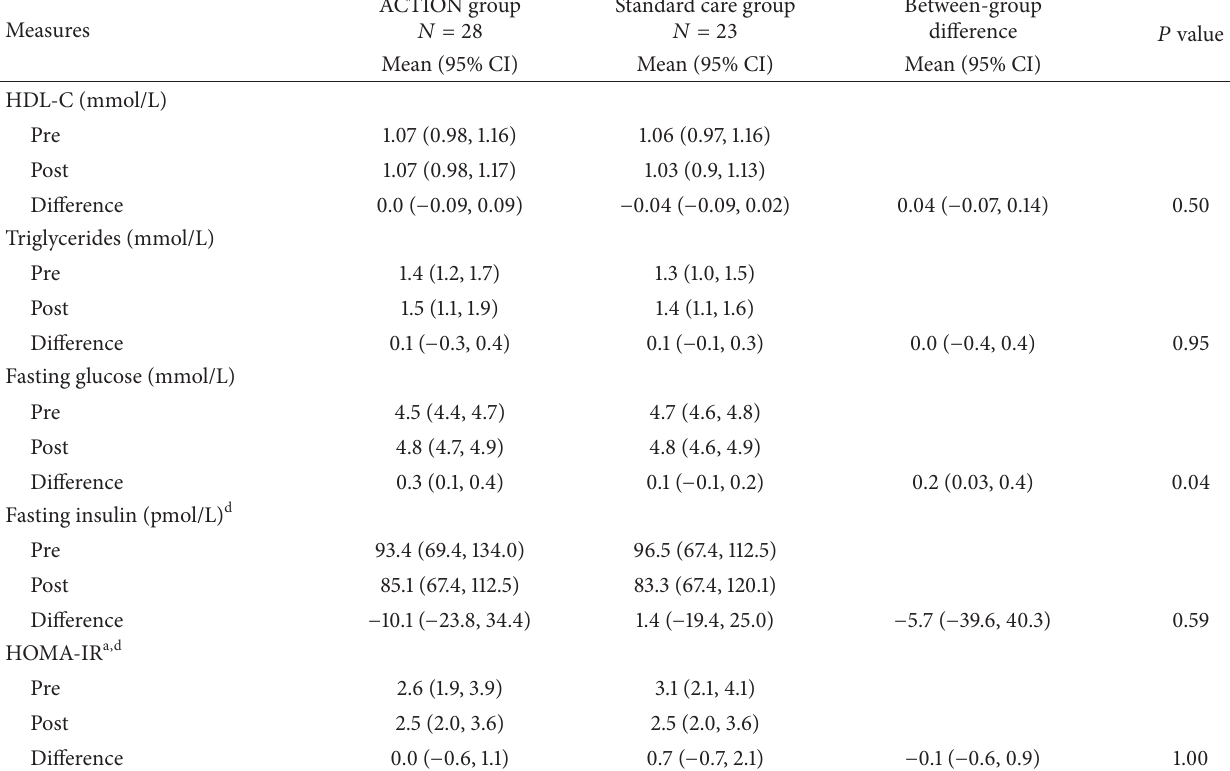
Table 5: Comparison of biochemical measures between ACTION and standard care